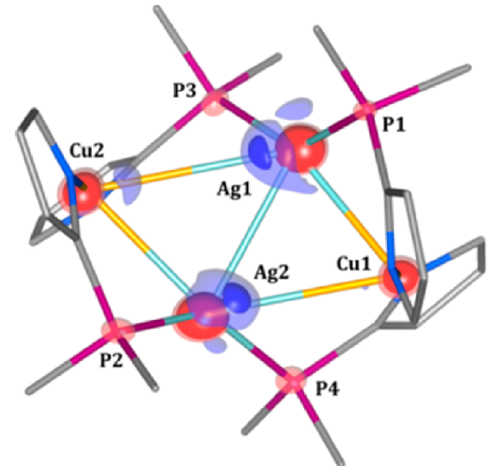
Figure 9. Photodifference map for the tetranuclear silver(I)-copper(I) complex (blue surfaces—positive values, red—negative; ligand fragments are omitted for clarity). Figure reproduced with permission from Jarzembska et al. [21]. Copyright (2014) American Chemical Society.